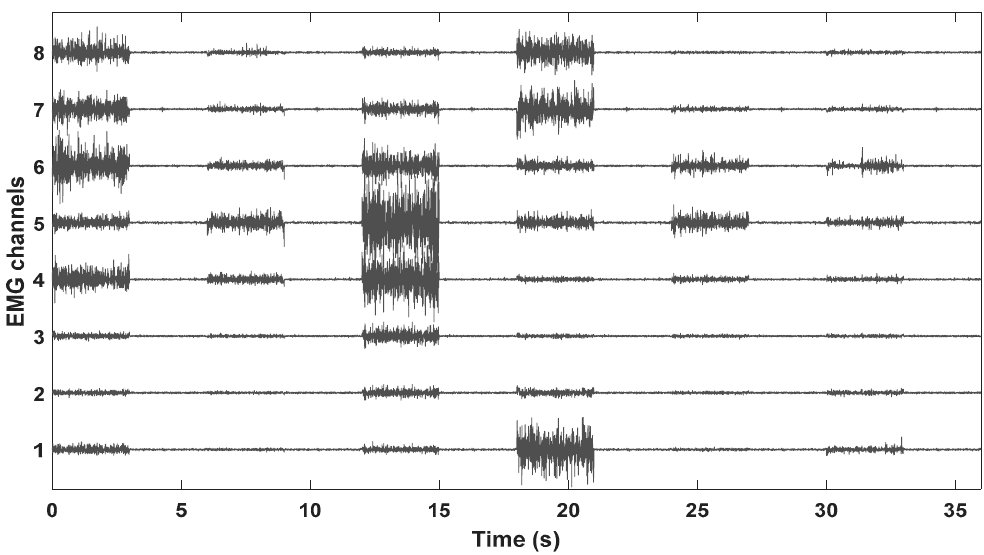
Figure 4. Electromyography (EMG) data recorded via wearable sensors for one repetition from a randomly selected session. The first and last half second of each movement type was removed to avoid transition artifacts. Hence, it shows 3 s of each movement with a rest period of 3 s.